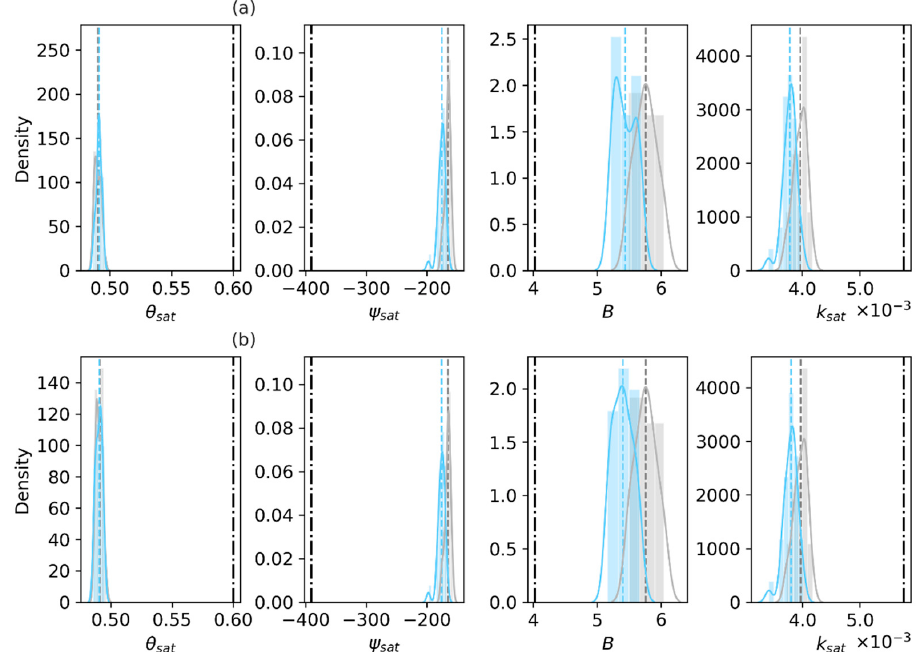
assimilation. The B